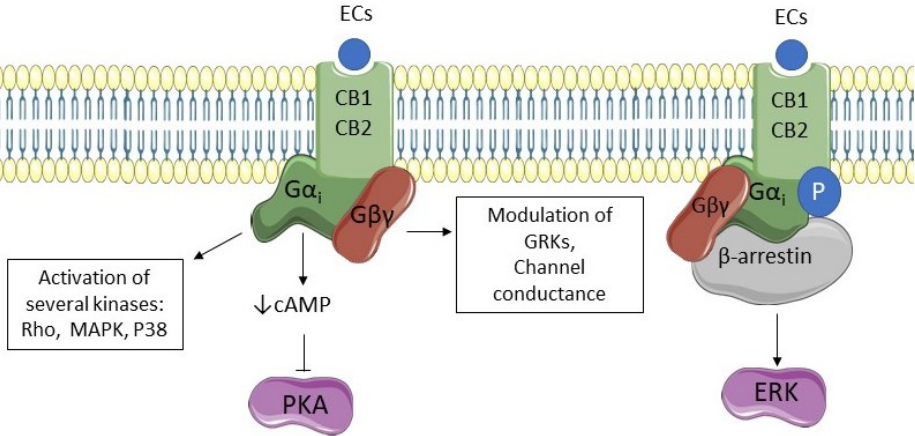
Figure 2. CB1 and CB2 signaling pathways. Endocannabinoids (ECs) stimulate cannabinoid receptors type 1 and 2 (CB1 and CB2, respectively), activating G-protein subunits. Subunit G α decreases cyclic AMP (cAMP) and inhibits the activity of protein kinase A (PKA). Moreover, it is responsible for the activation of several kinases such as mitogen-activated protein kinase (MAPK), P38, and Rho kinase. Subunit G βγ activation modulates channel conductance and the activity of G protein receptor kinases (GRKs). Both receptors can be phosphorylated by GRKs and associate with β -arrestin leading to receptor internalization and extracellular-signal related kinase (ERK) pathway activation.